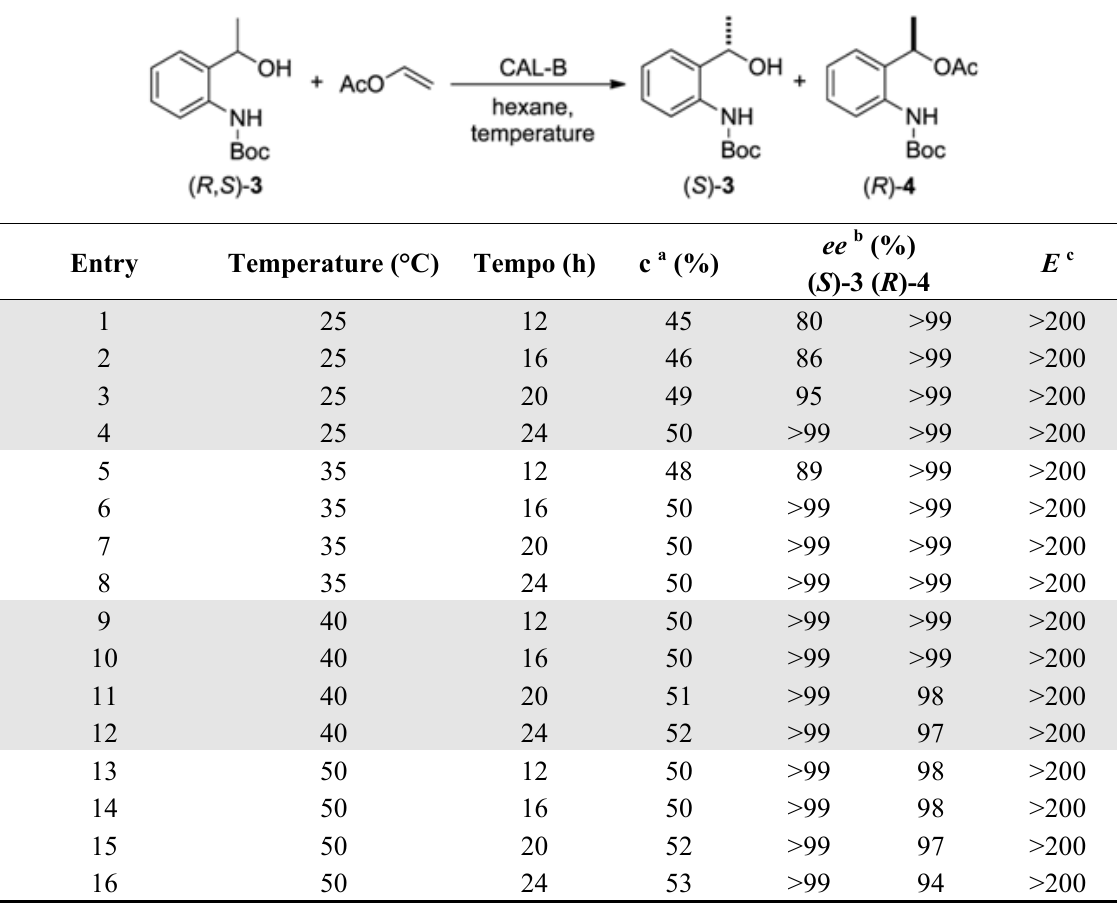
Table 4. Influence of temperature in the lipase-catalyzed transesterfication of ( R,S )- 3